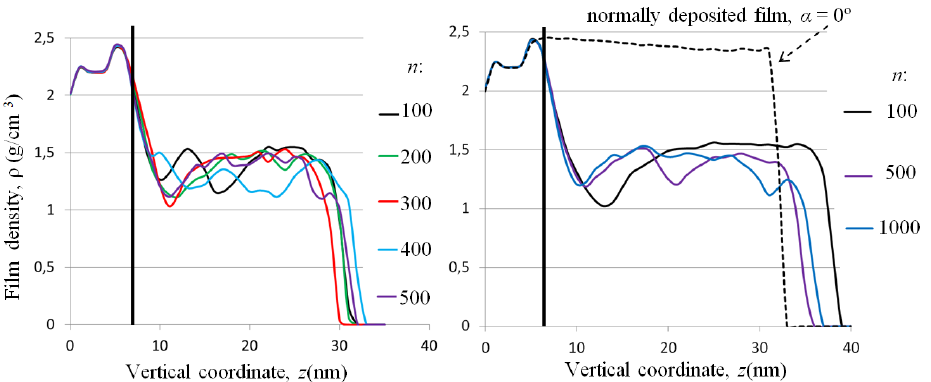
Figure 4. Density profiles of the films deposited on small substrate ( left ) and large substrate ( right ). Atomistic structures are shown in Figures 2 and 3. Energy of deposited Si atoms is 10 eV, deposition angle α = 80°, n is the number of injection steps between subsequent alternations of α. Vertical black line denotes the substrate boundary before the deposition.